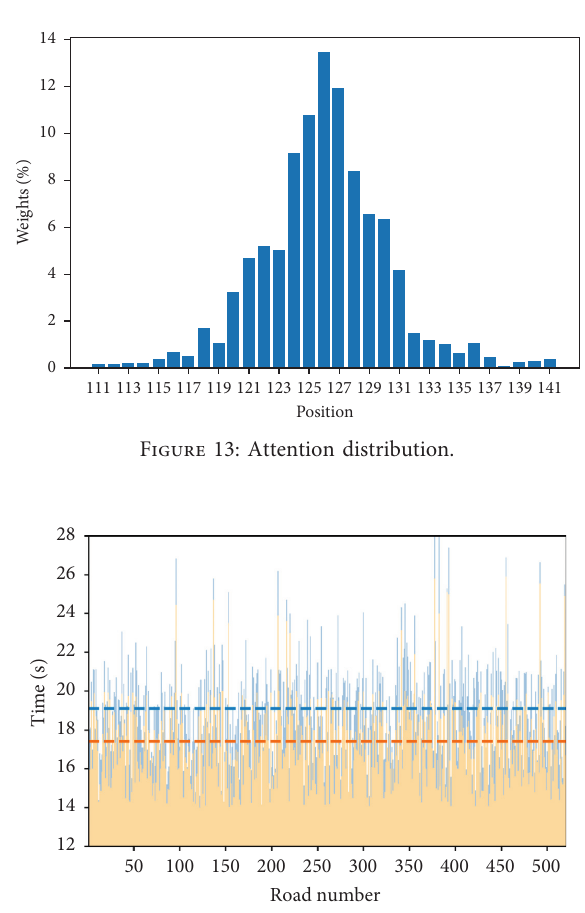
Figure 14: Training time of proposed model on each road segment with and without the attention mechanism.